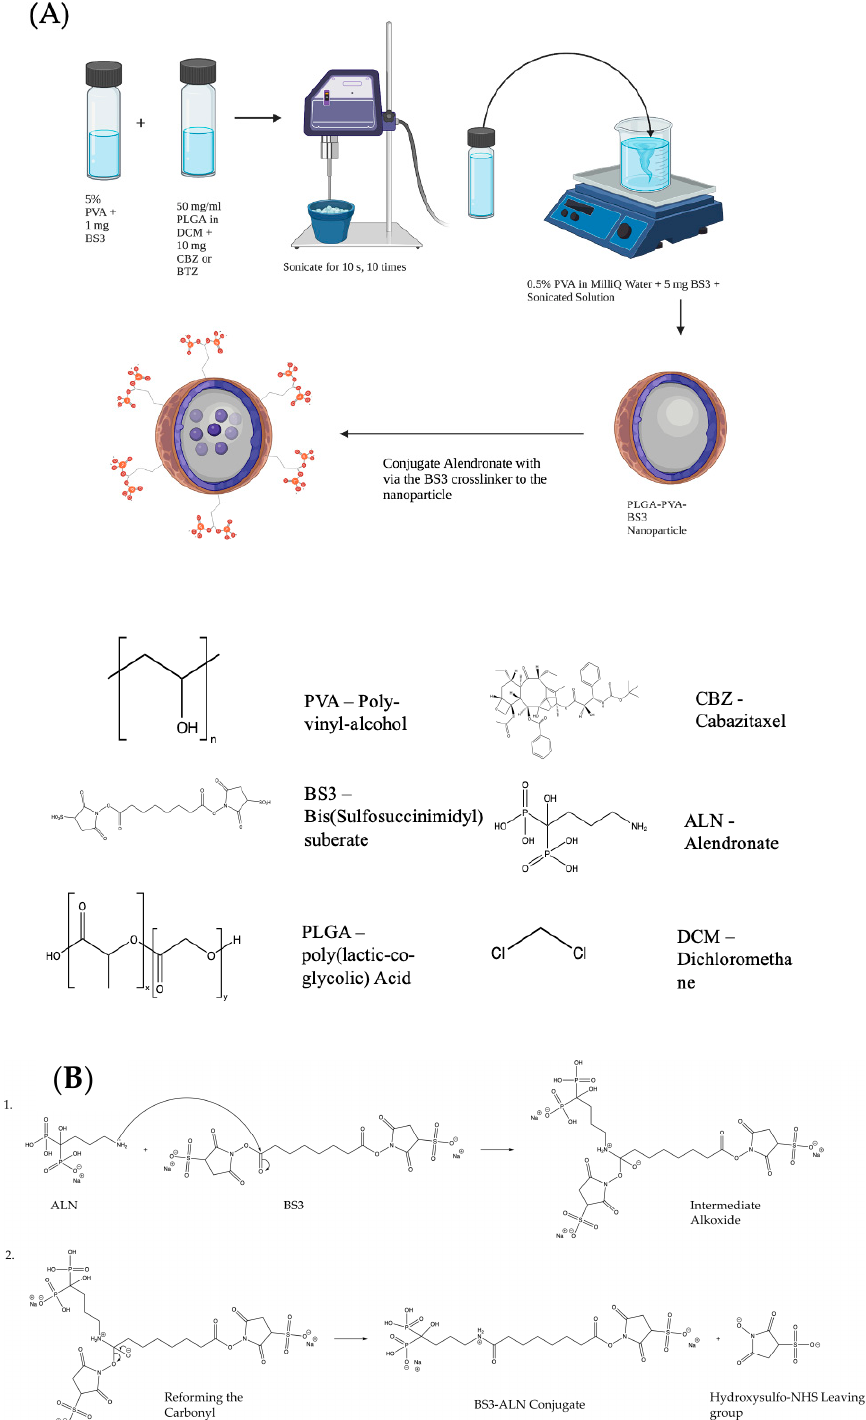
Figure 1. ( A ) Schematic representing the Emulsion-Diffusion-Evaporation Technique for preparing drug-loaded NPs. Schematic created using Biorender.com and ChemDraw. ( B ) Conjugation of Alendronate to the BS3 Crosslinker confers bone-targeting to the drug-loaded nanoparticle. (1) The nitrogen of the 1 ◦ amine on the alendronate performs a nucleophilic attack on the carbonyl of the sulfo-NHS ester on the BS3 linker. A proton is taken by a basic species in solution to leave the intermediate alkoxide, which, in (2), reforms the carbonyl, displacing the hydroxysulfo-NHS leaving group to complete the amide formation. Image created with